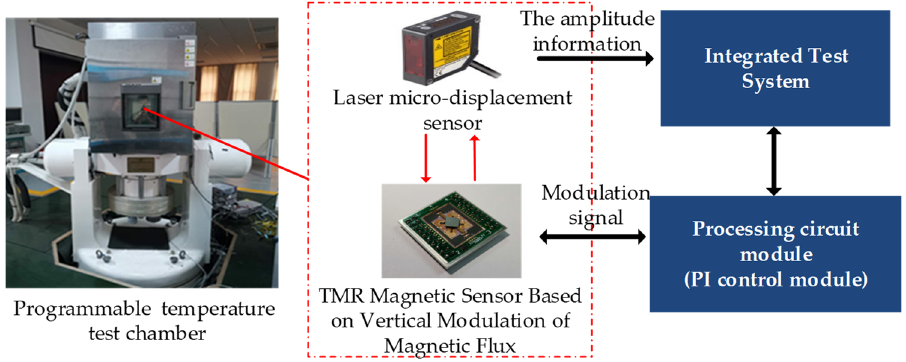
Figure 5. Schematic diagram of amplitude temperature drift compensation based on the harmonic component of the modulated signal.